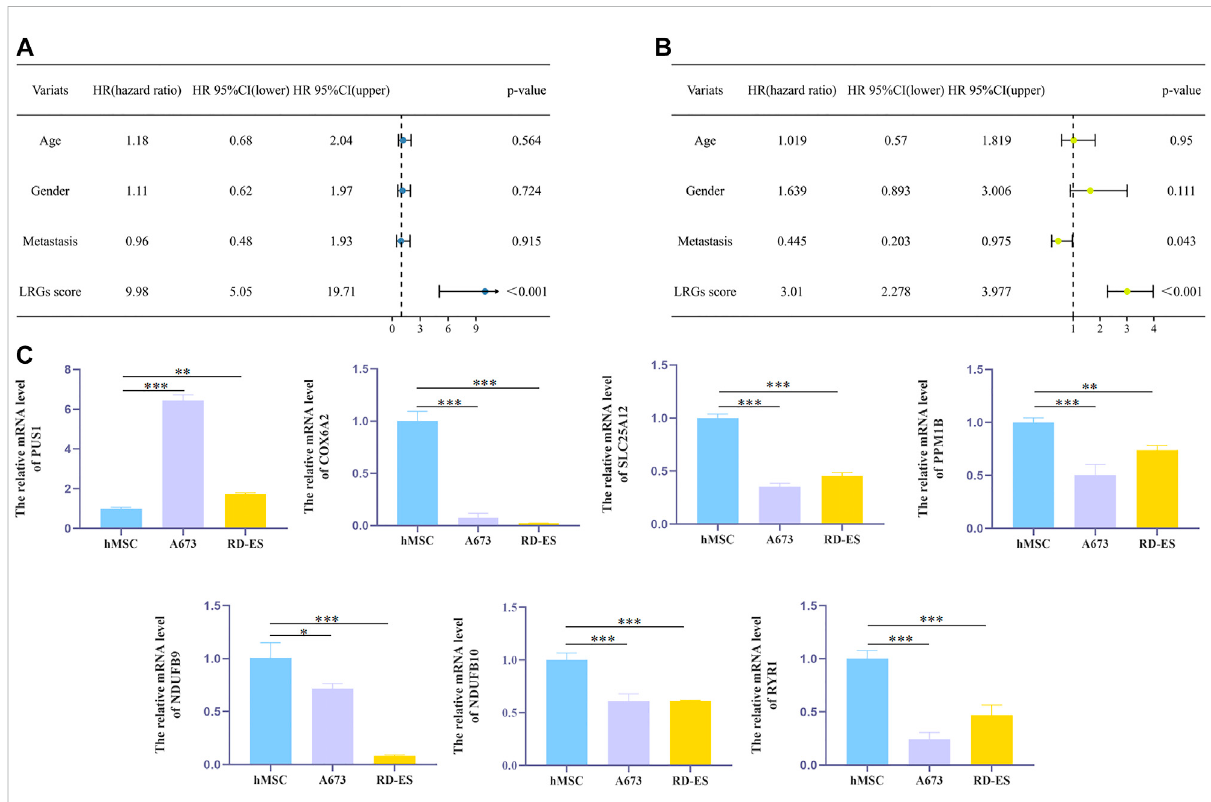
FIGURE 7 The effect of independent factors on LRGs scores and qPCR analysis (A,B) . Univariate and multivariate Cox analyses via integrating LRGs scores and clinical characteristics in the training cohort (C) . qPCR analysis to verify the expression level of candidate genes in cells. * p < 0.05; ** p < 0.01; *** p <